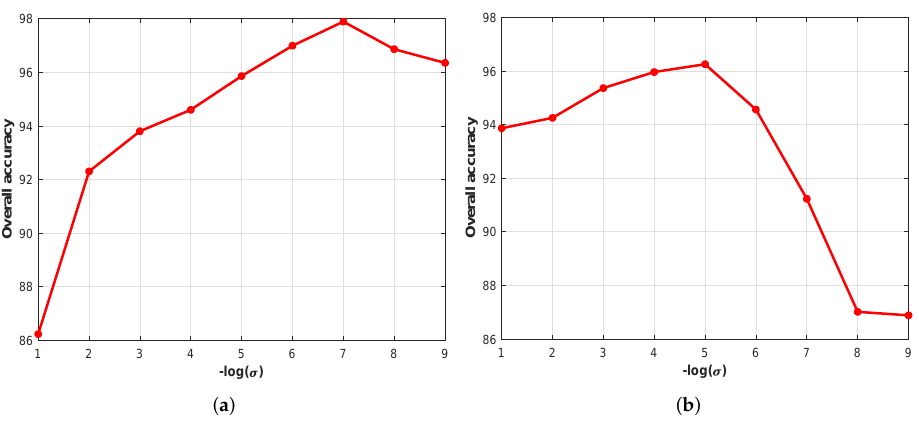
Figure 4. Classification accuracies of the proposed MASEMAP-MKL method as a function of param- eter σ : ( a ) IP; ( b ) UP.